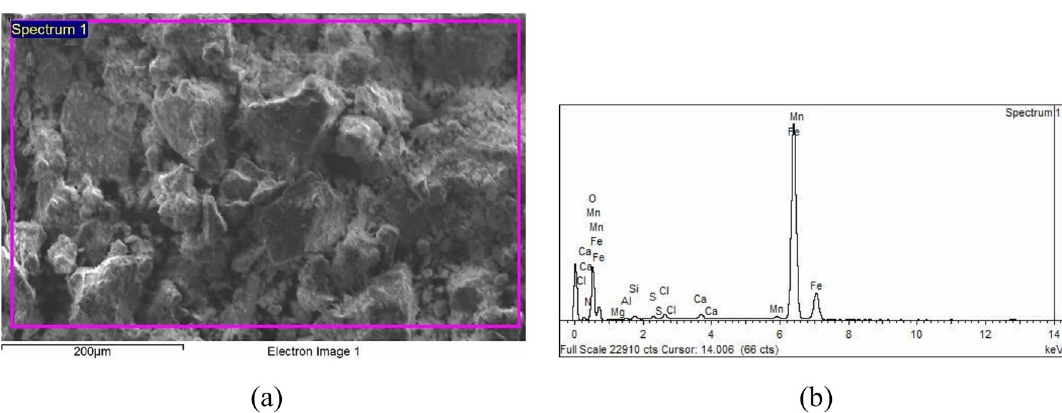
Figure 14. SEM backscattered image and EDS microanalysis of the corrosion products of UB1-B2: ( a ) SEM micrograph of the corrosion product, ( b ) the EDS analysis pattern